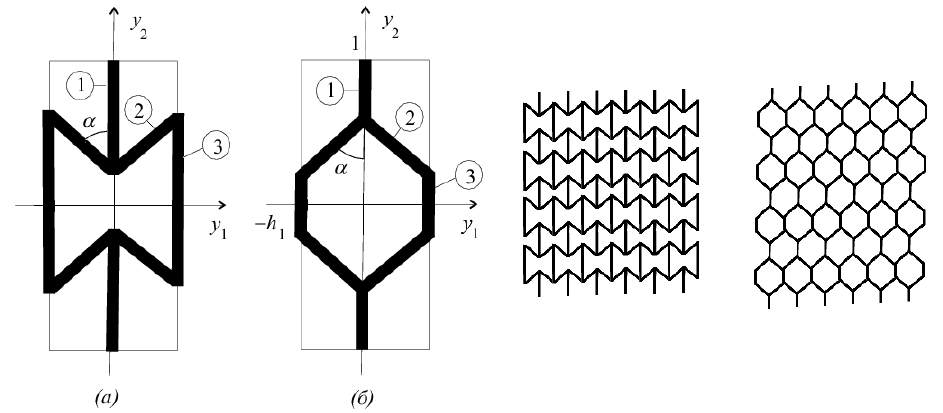
Figure 4. Honeycomb-like periodicity cells: ( a ) inverted honeycomb-like cell and ( b ) standard honeycomb cell and the corresponding